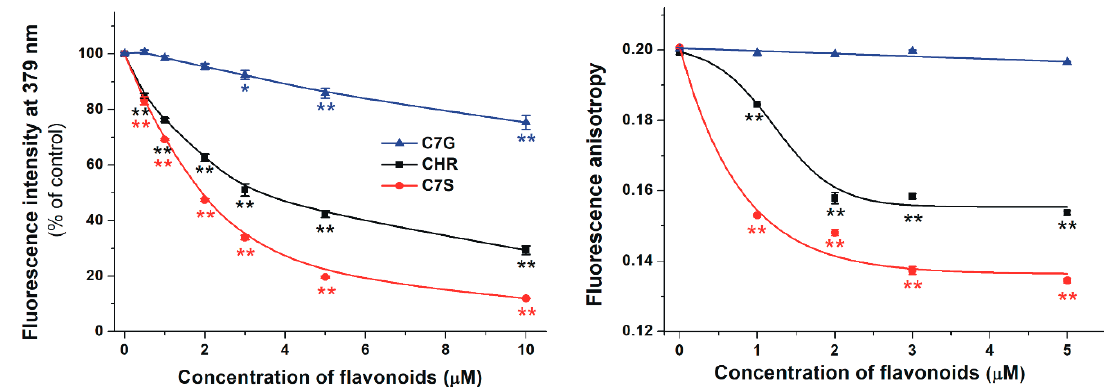
Figure 5. Left: A concentration-dependent decrease in the fluorescence emission intensity of the warfarin–HSA complex (1.0 and 3.5 µmol/L of warfarin and HSA, respectively) in the presence of increasing flavonoid concentrations (0.0, 0.5, 1.0, 2.0, 3.0, 5.0, and 10 µmol/L). Right: Fluorescence anisotropy values of the warfarin–HSA complex (1.0 and 2.0 µmol/L of warfarin and HSA, respectively) in the presence of increasing concentrations of chrysin, C7S, or C7G (0.0, 1.0, 2.0, 3.0, and 5.0 µmol/L). ( λ ex = 317 nm, λ em = 379 nm; * p < 0.05, ** p < 0.01; CHR: chrysin; C7S: chrysin-7-sulfate; C7G: chrysin-7 glucuronide).